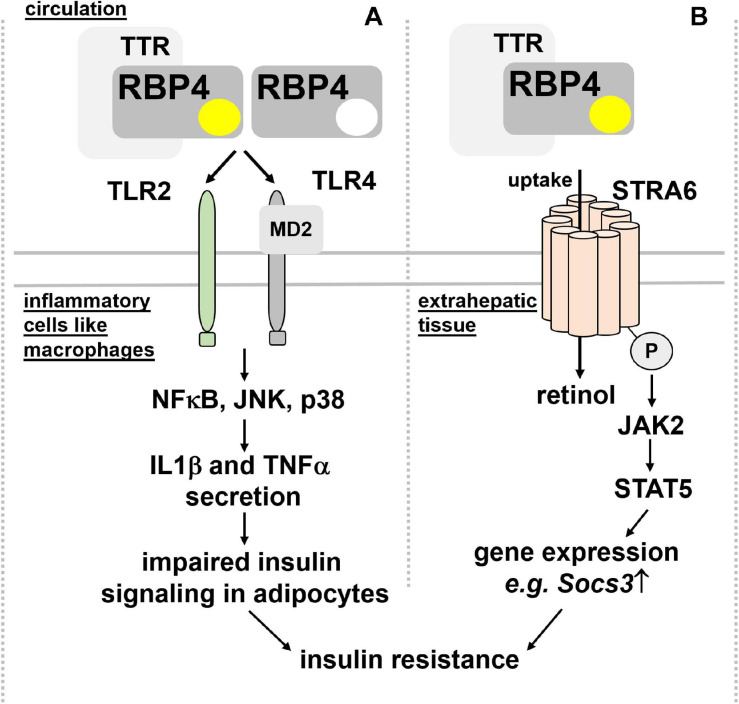
Proposed mechanisms for RBP4’s detrimental effects on insulin sensitivity. (A) RBP4, irrespective of its association with retinol and thus independent of retinol transport, was shown to activate TLR2/4 on inflammatory cells like macrophages. A downstream signaling cascade involving NFκB, JNK, and p38 leads to the secretion of IL1β and TNFα, which, in turn, impairs insulin signaling in adipocytes and leading to insulin resistance. (B) Binding of holo-RBP4 to STRA6 was shown to trigger tyrosine phosphorylation of the membrane receptor, resulting in recruitment and activation of JAK2 and the transcription factor STAT5. As a consequence, the induction of STAT5 target genes like Socs3 impairs insulin signaling. IL1β, interleukin 1β; JAK2, Janus kinase 2; JNK, c-Jun N-terminal kinases; NFκB, nuclear factor κ-B; MD2, myeloid differentiation protein-2; RBP4, retinol binding protein 4; Socs3, suppressor of cytokine signaling 3; STAT5, signal transducer and activator of transcription 5; STRA6, stimulated by retinoic acid 6; TNFα, tumor necrosis factor α; TLR2/4, toll-like receptors 2/4; TTR, transthyretin.